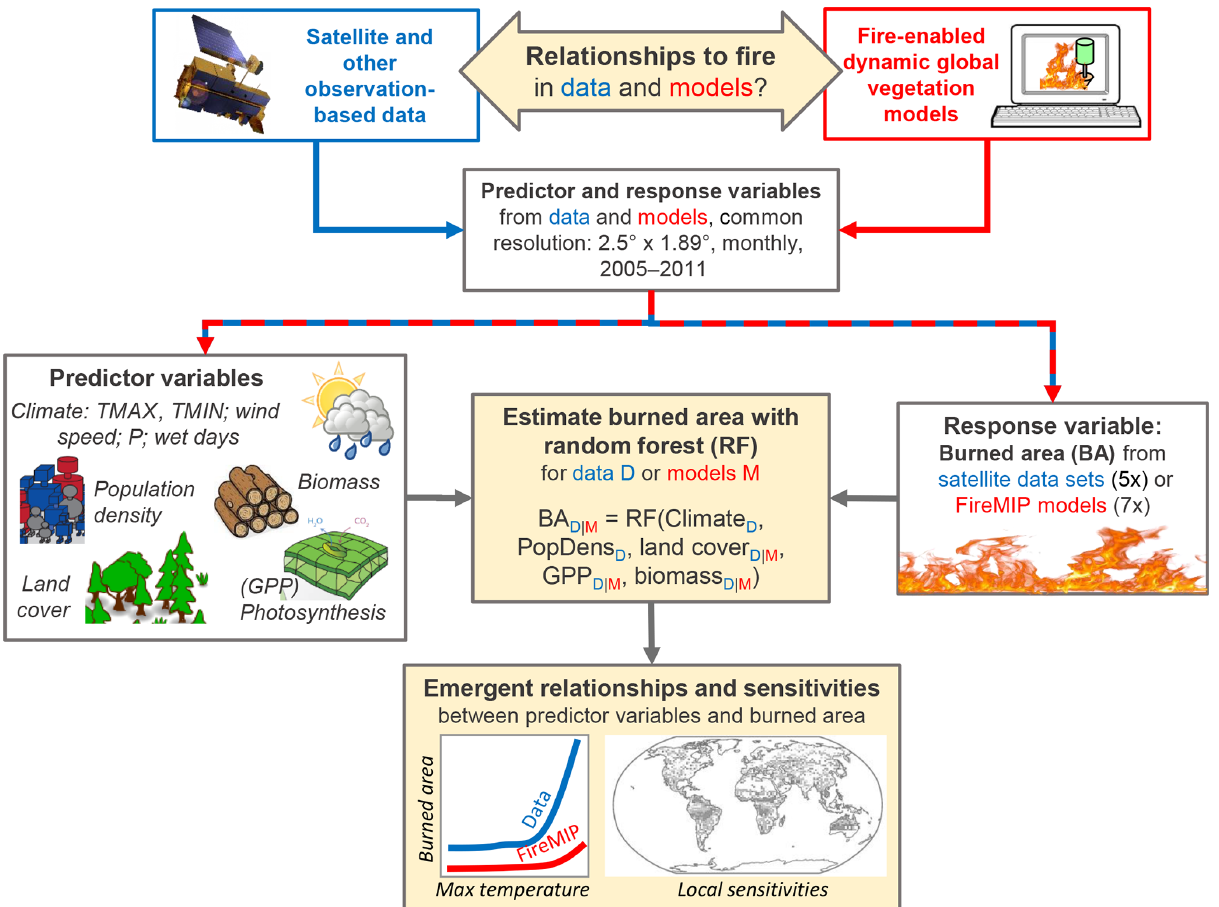
Figure 1. Overview of the approach for using the random forest machine learning algorithm to derive emergent relationships between several predictor variables for burned area from satellite and other observation-based data and in fire-enabled